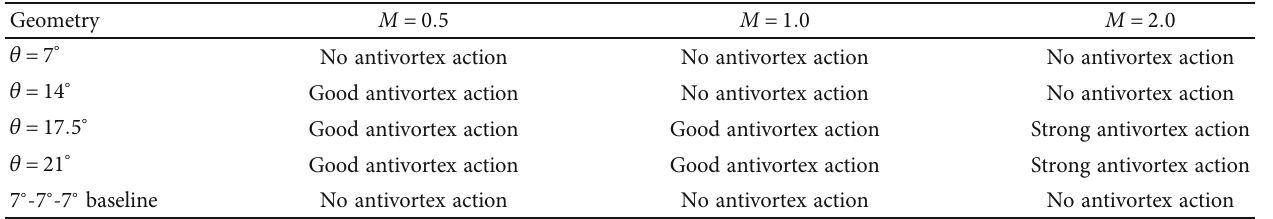
Figure 27: CFD vorticity magnitude contours and velocity vectors at z / d = 0 : 05 (looking down on the target plate). Table 3: Antivortex performance of di ff erent